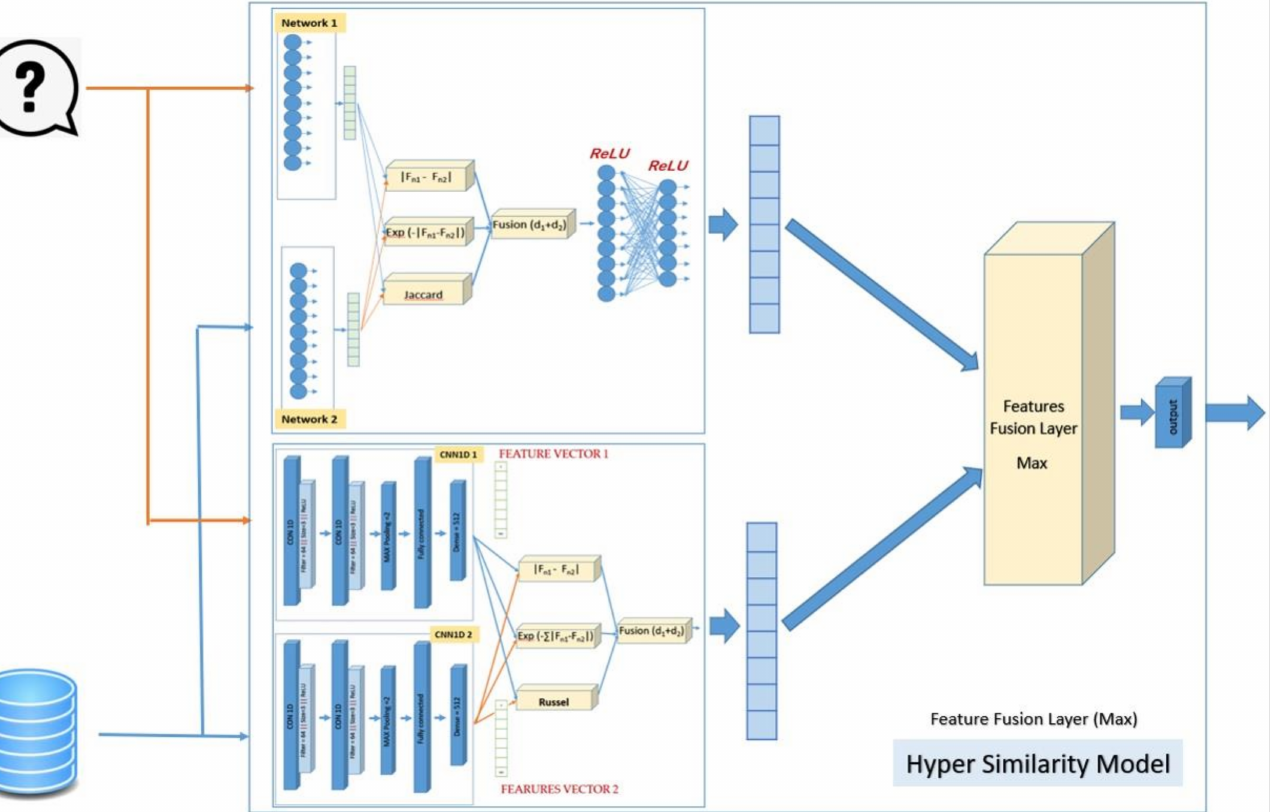
Figure 5. The design of the hybrid Siamese similarity model with three similarity measures using feature fusion